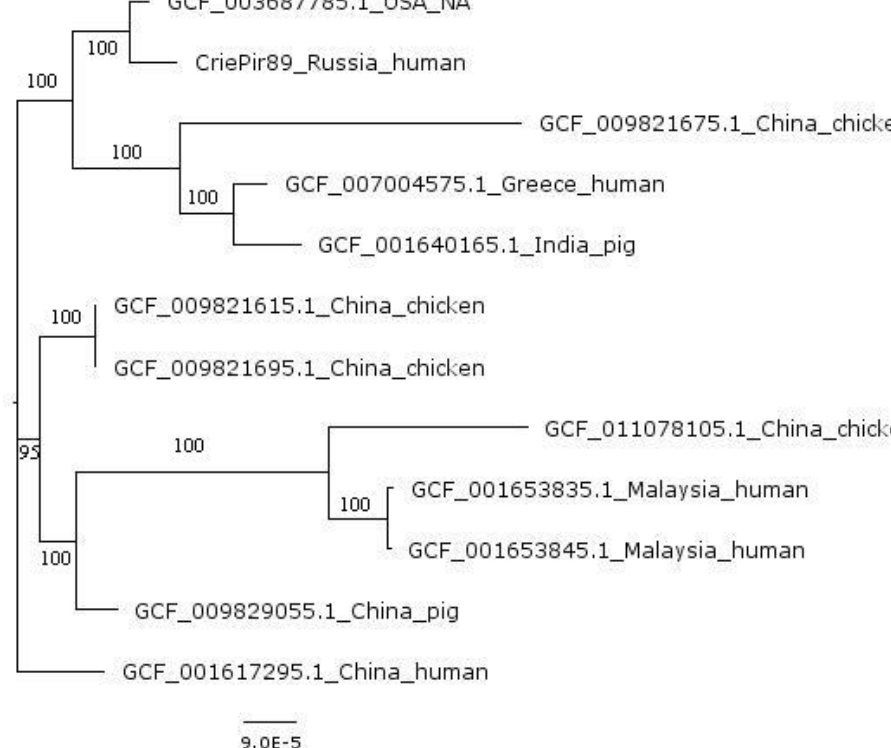
Figure 3. Phylogenetic tree for the nearest neighbors of CriePir89 from Genbank. Country and source of origin are indicated.